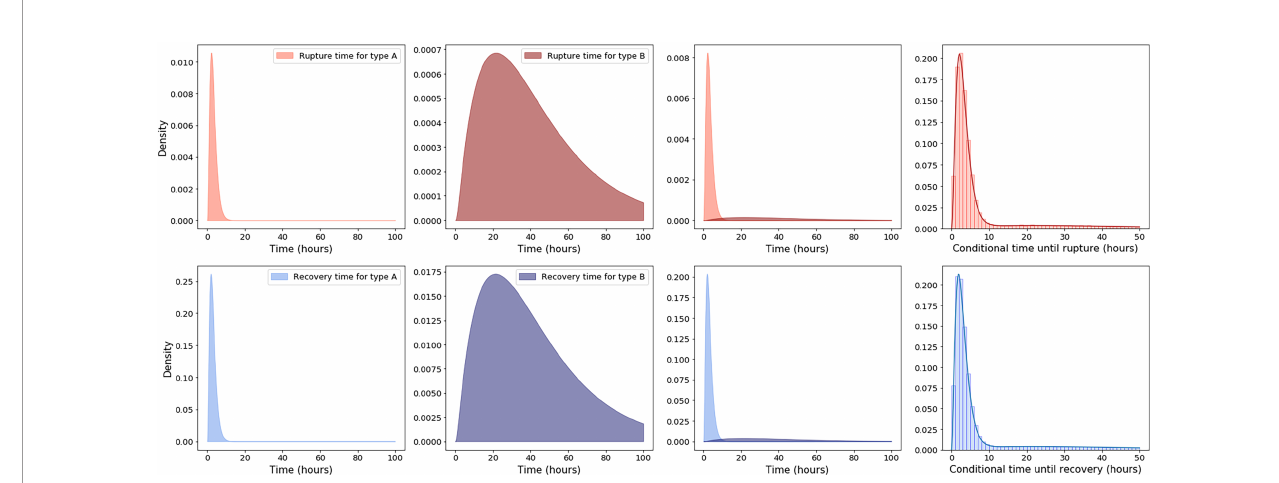
FIGURE 6 | Top row, from left to right, the fi rst two plots show the probability density functions for the rupture time of a macrophage infected with a spore of type A ( t ; g A ) and f T R ( t ; g B ). The third plot shows these densities on the same plot, when they are scaled by the relative frequencies and type B, respectively, given by f T R 1 S 1 S ( t ; g A ) and (1 − e ) f T R ( t ; g B ). The fourth plot shows as a solid line the probability density function for the rupture time of a macrophage of each germination rate: e f T R 1 S 1 S infected with a single spore, conditioned on rupture occurring, which is given by f T R ( t )/ r R 1 . Also shown on the fourth plot is a histogram of the fi nite rupture times 1 S S from 10 6 stochastic simulations of the model in Figure 1 . Plots on the bottom row correspond to the analogous densities for the time to recovery of an infected macrophage. The estimated parameter values in Table 5 were used to compute these